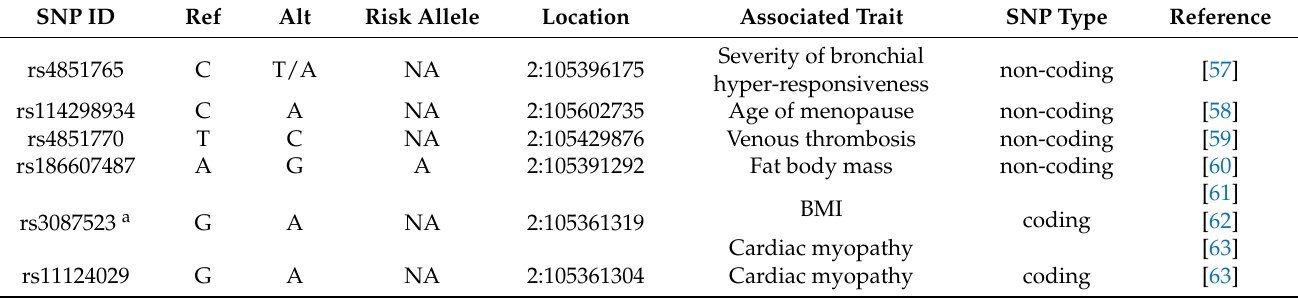
Table 1. FHL2 SNPs and associated traits. The table denotes the FHL2 genetic polymorphisms that are associated with a disease or trait, according to the literature. Here, we indicate the reference allele (Ref), the alternative allele (Alt), the location of the SNP on chromosome 2 (Location), the associated trait, whether the SNP is within the coding, non-coding, or intergenic region (SNP type), and the reference article (Reference). SNPs rs3087523 and rs62155873 ( a ), rs1401209, and rs7563316 ( b ) and rs3943516 and rs6741486 ( c ) are marked as they form LD pairs with each other, respectively (see also Figure